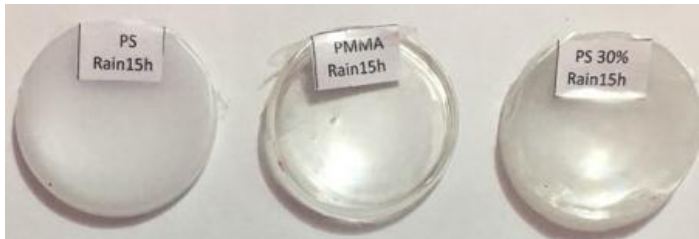
Fig.8: Shows 15hr rain for PMMA, PS, 30%PMMA\PS.